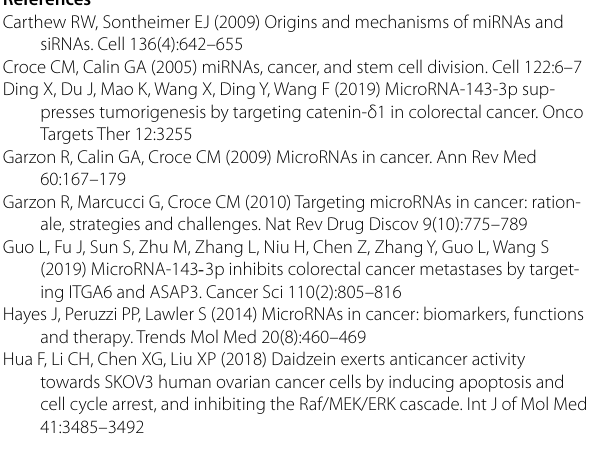
Fig. 5 a Expression of MAPK3 in si-NC and si-MAPK3 transfected CAMA-1 cells. b Cell viability of si-NC and si-MAPK3 transfected CAMA-1 cells. c Cell viability of si-NC, si-MAPK3, si-MAPK3 miR-143 + inhibitor and miR-143 mimics pcDNA-MAPK3 transfected CAMA-1 + cells. The experiments were performed in triplicate and expressed as mean SD (*P < ±